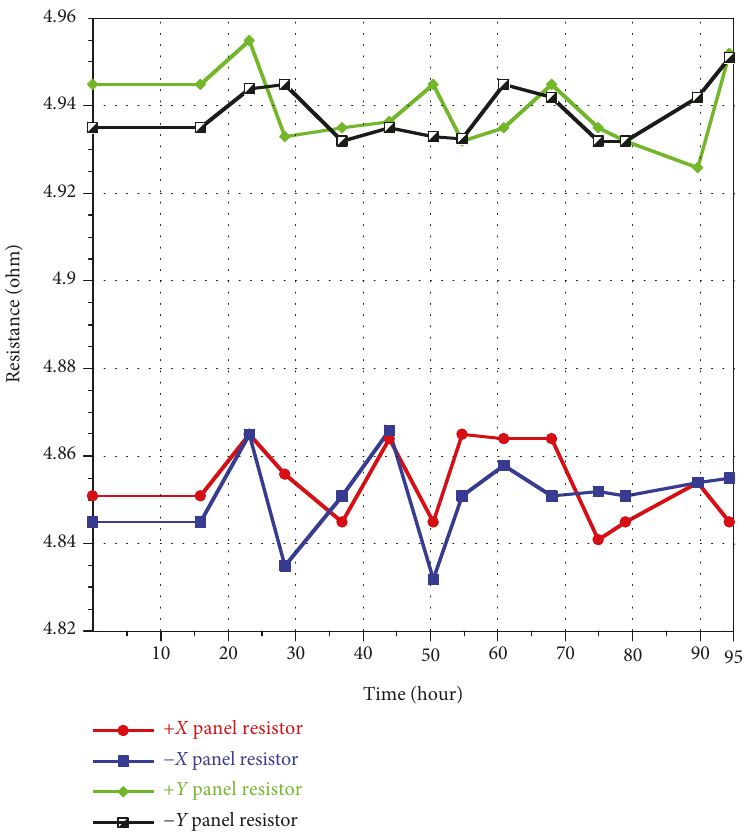
Figure 14: Variation in resistance values of the burn resistors during the TV test.